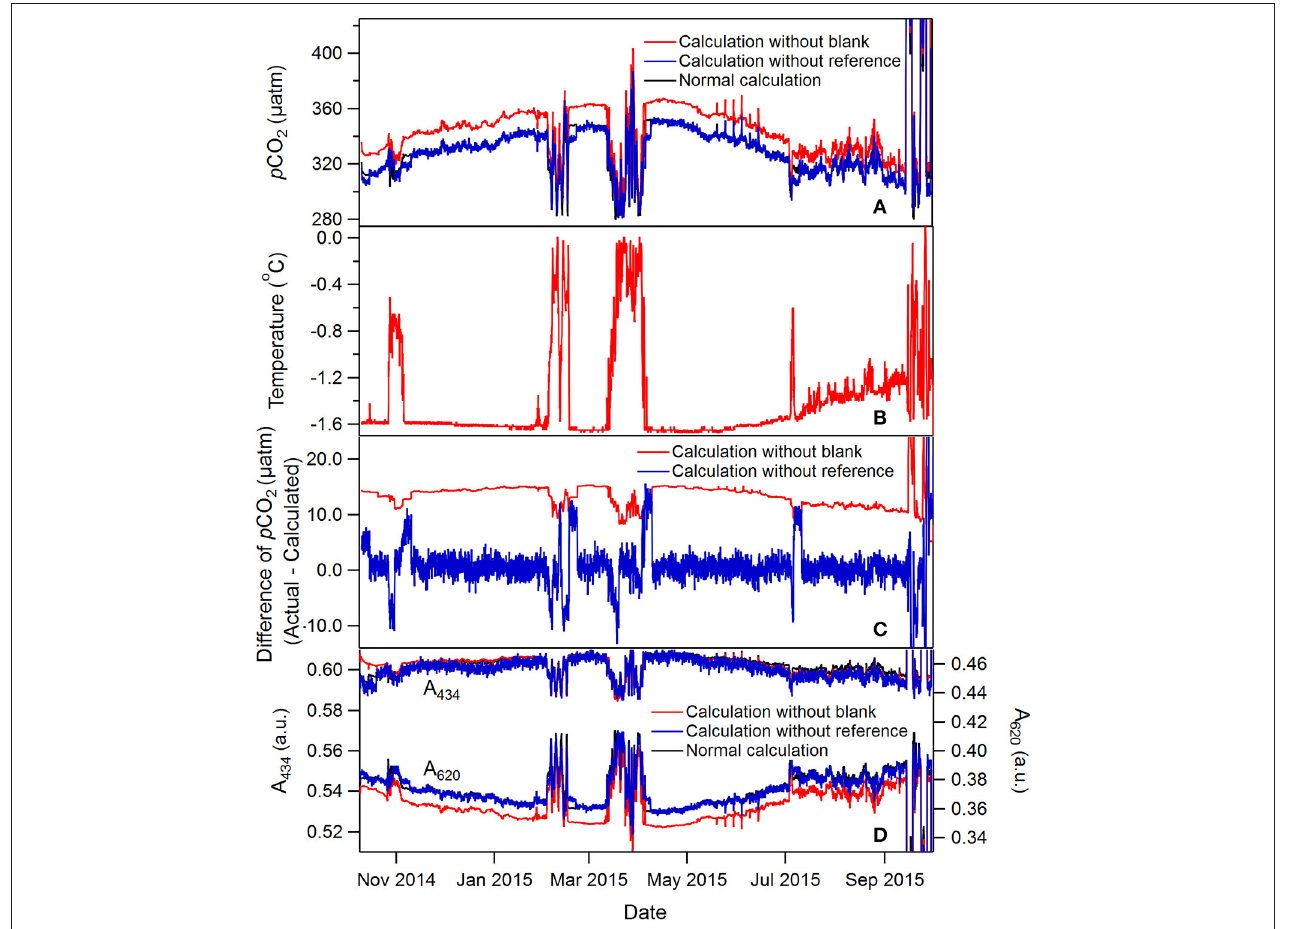
FIGURE 4 | A 1-year time series of p CO 2 and temperature collected by a SAMI-CO 2 on a subsurface mooring ( ∼ 35m depth) in the Canada Basin of the Arctic Ocean (78 ◦ N, 150 ◦ W) (A,B) . The rapid and large p CO 2 excursions were caused by pull down of the mooring by large eddies (to as deep as ∼ 280m). The p CO 2 and absorbance data with and without blank and reference measurement intensity corrections (Equation 8) are also shown (C,D) . See text for more discussion. The normal calculation values (black curves) are hidden under the calculation without reference (blue